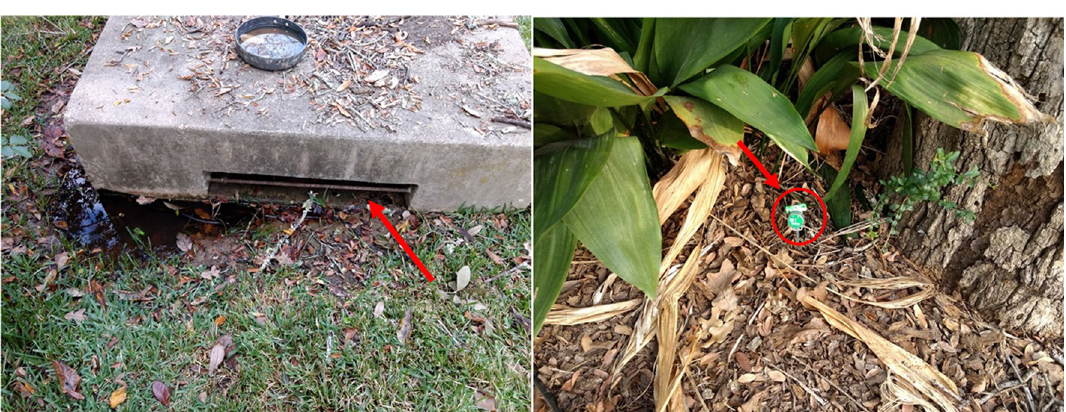
Figure 2. Logger placements: (left) inside storm drain, (right) under the